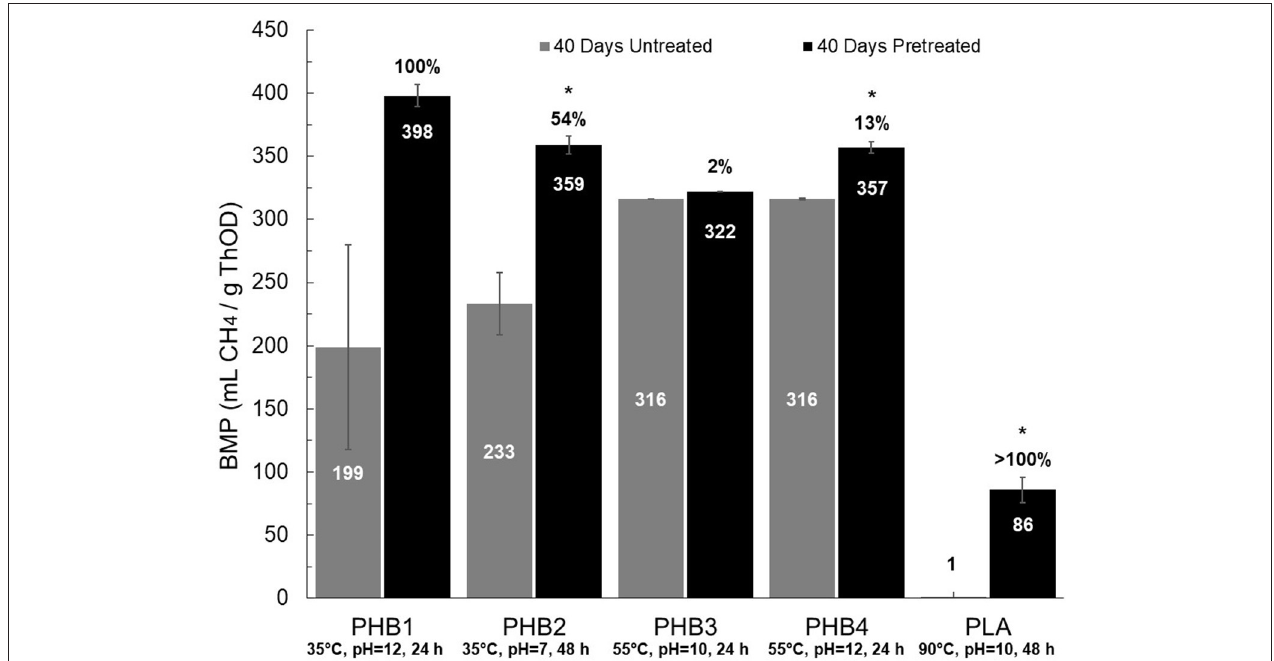
FIGURE 2 | BMP values for untreated (gray) and pretreated (black) bioplastics under conditions resulting in the greatest biomethane increase. The specific conditions are written under each bar in the graph (temperature, pH, duration). BMP values, shown within each bar, with 40 days duration are reported at 35 ◦ C and ambient pressure. Percentages above black bars indicate relative increase from untreated to pretreated, with statistically significant differences at 95% confidence denoted by an asterisk (*). Error bars are relative standard deviation (n = 3); some error bars are small and not visible.